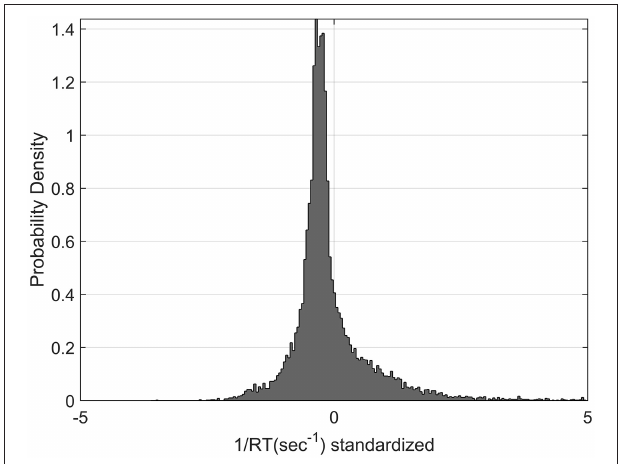
FIGURE 9 | Standardized Rate Distributions obtained by collapsing the standardized rate for all participants and all conditions (see Materials and Methods). The distribution is clearly not normal. Similar shapes were found when analysing each condition